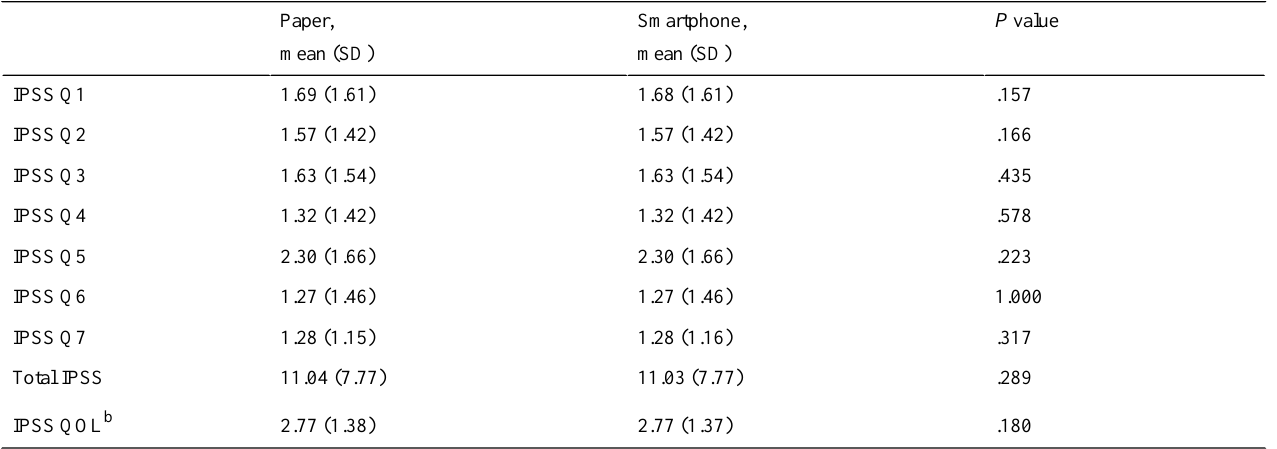
Table 2. Paired t test between paper and smartphone IPSS a .